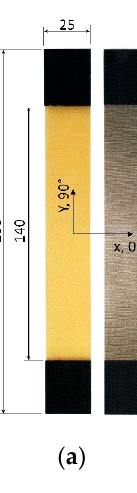
Figure 7. Overview of the test specimens (all dimensions in mm): ( a ) transverse tension; ( b ) longitudinal tension, ( c ) longitudinal tension with electrical contacts.